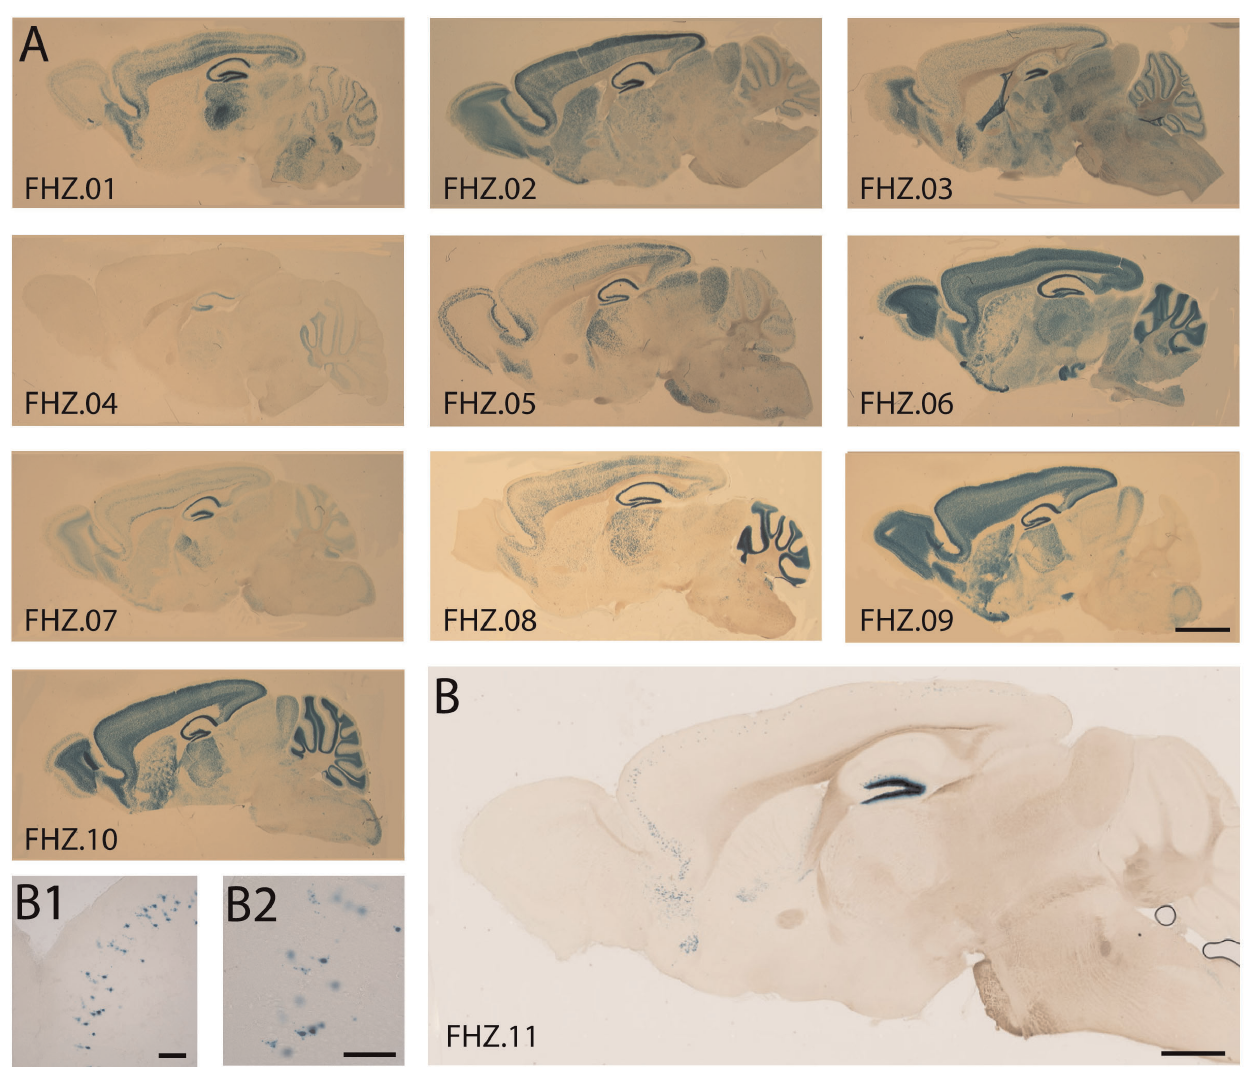
Figure 2. Labeling of subsets of neurons in hsp68-nlacZ lines. (A), (B) Sagittal sections of mice carrying a single copy of the hsp68-nlacZ transgene. A large variety of subsets of neurons was labeled in eleven independent mouse lines labeled FHZ.01 to FHZ.11 ((A) bar=1.5 mm, (B) bar=1 mm). (B1), (B2) Higher magnification views show a population of labeled cortical neurons in the frontal cortex of the brain shown in B (both bar=100 um).